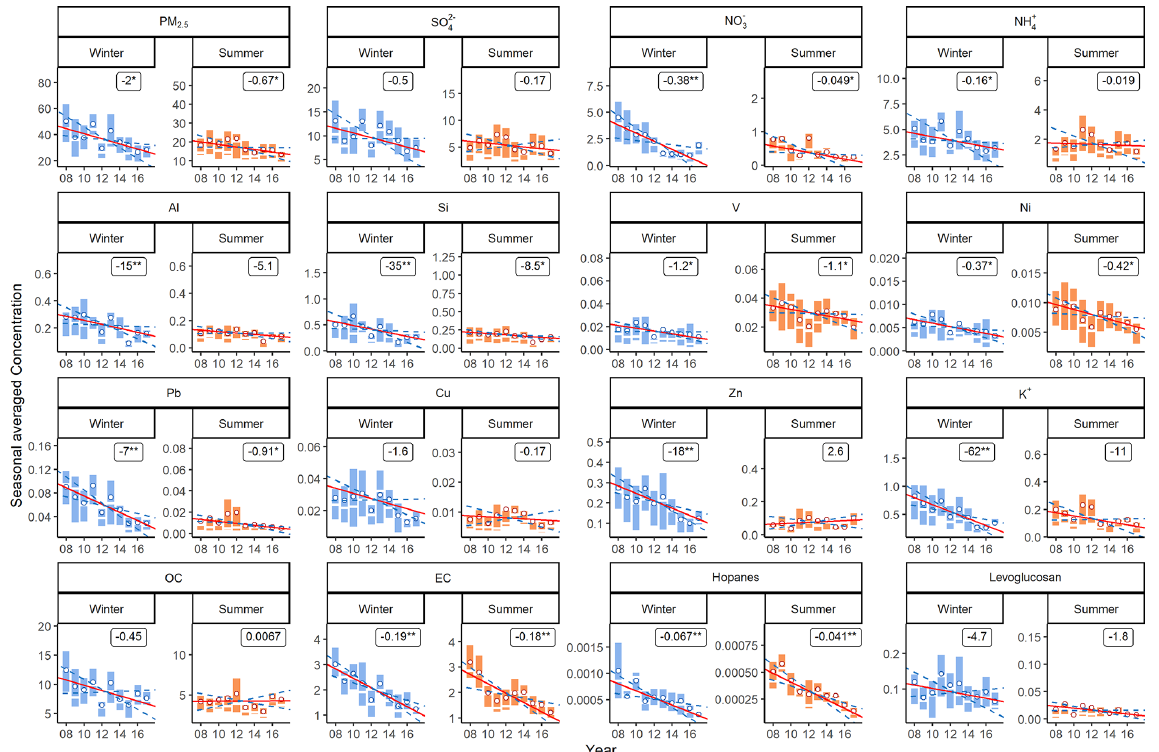
Figure 6. The 10-year variations of seasonal average concentrations of PM 2 . 5 and selected components for the winter (blue) and summer (orange) from 2008 to 2017. Red lines indicate Sen’s slope, and dashed blue lines indicate the 95% confidence intervals.